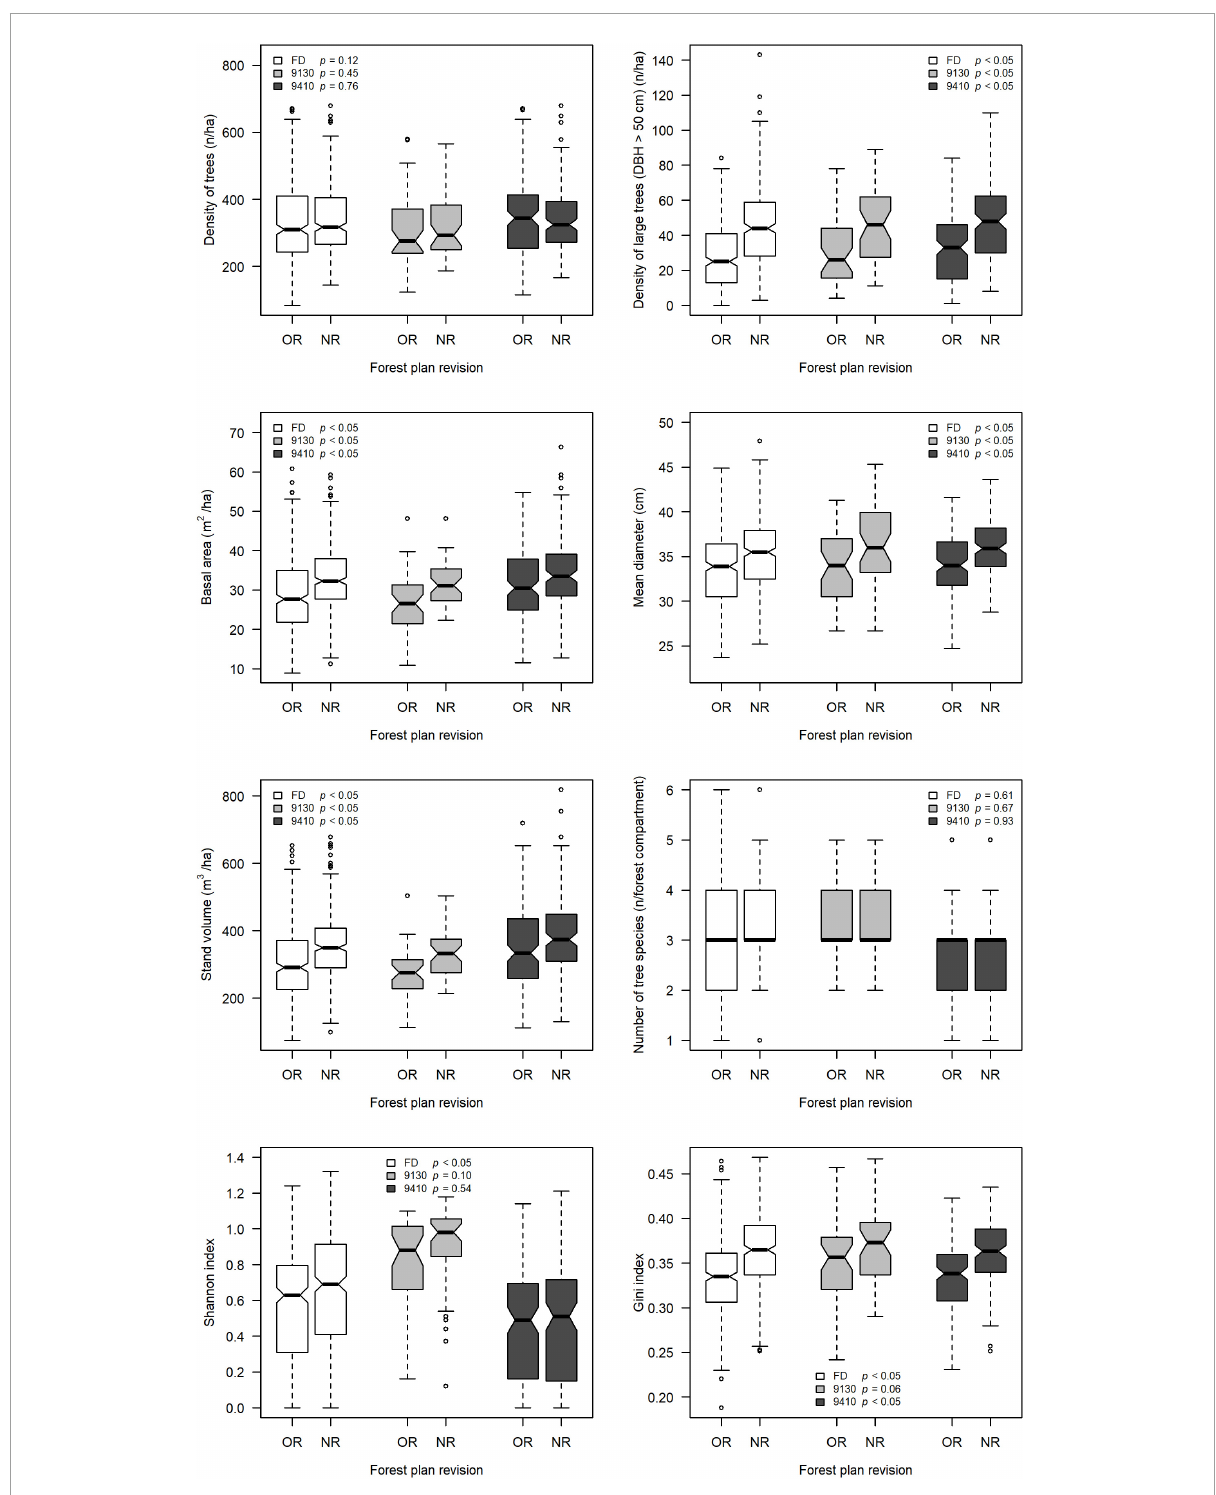
FIGURE2 The boxplots compare the distribution of the values of each of the structural indicators used in this study among OR (old revision) and the NR (new revision) of forest management plans. White boxplots refer to the whole of the 331 forest compartments belonging to the analyzed sample (FD = full database; n = 331); gray boxplots refer to the sample of forest compartments dominated by 9130 forest habitat type ( n = 43); dark gray boxplots refer to the sample of forest compartments dominated by 9410 forest habitat type ( n = 135). The p -values from the Wilcoxon–Mann–Whitney test are displayed in the